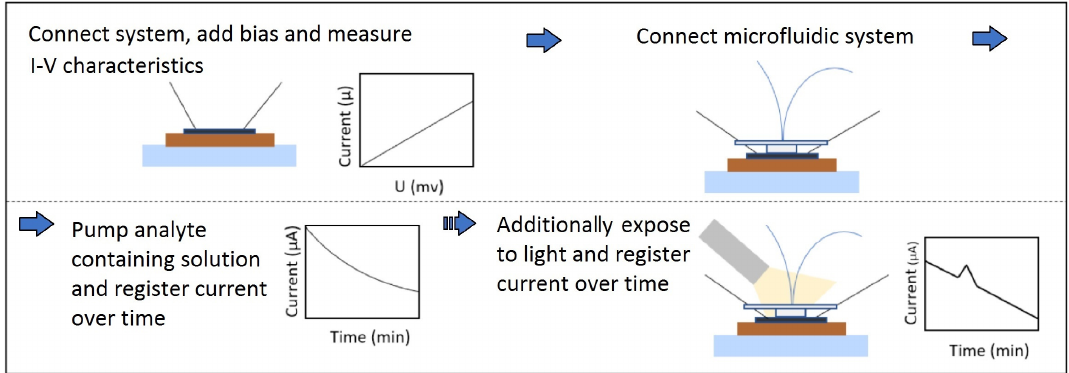
Figure 4. General scheme for the detection of different analytes with the fabricated graphene-based device including additional exposure to light to investigate the discovered photo-physical response.